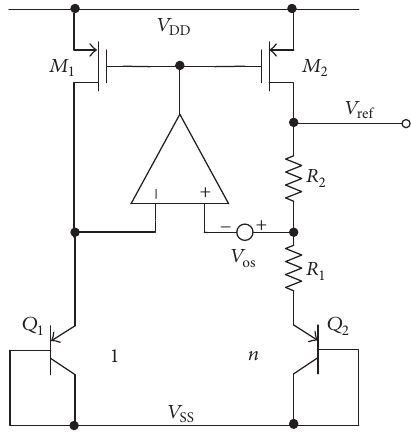
Figure 2: The traditional BGR